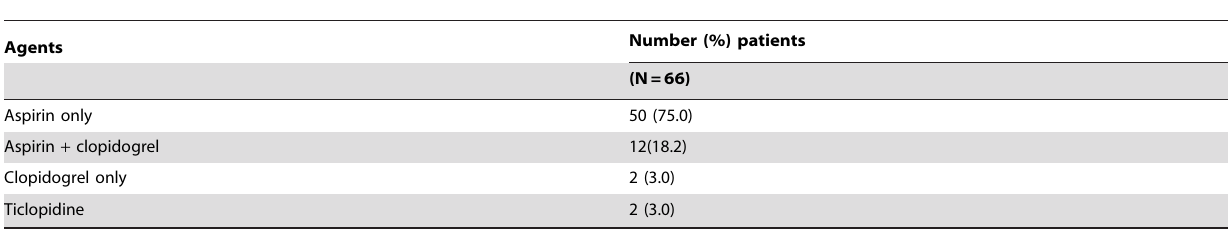
Table 3. Details of anti-platelet